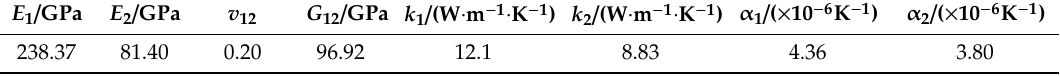
Table 2. Thermal-mechanical properties of 2D woven SiC / SiC composites.